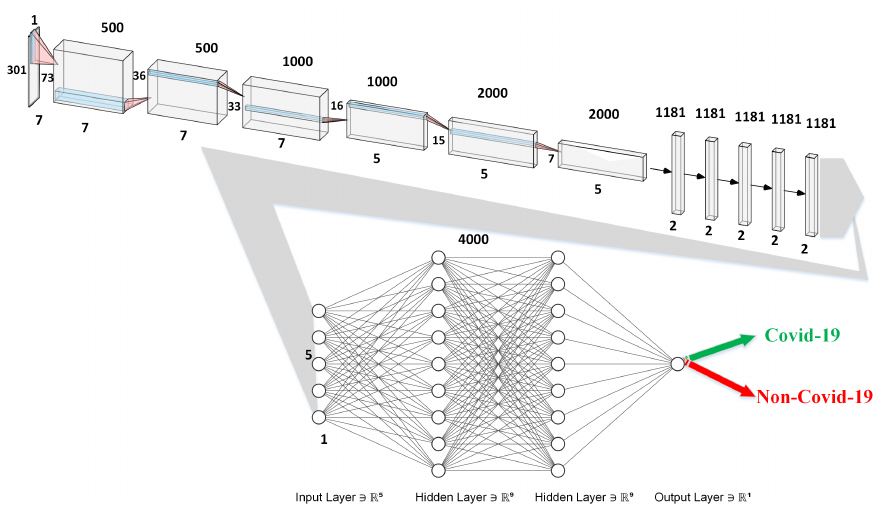
Figure 8. The topology of designed OptiDCNN. The number below of each box indicates the size of the outcome images, while the one above each box the number of filters